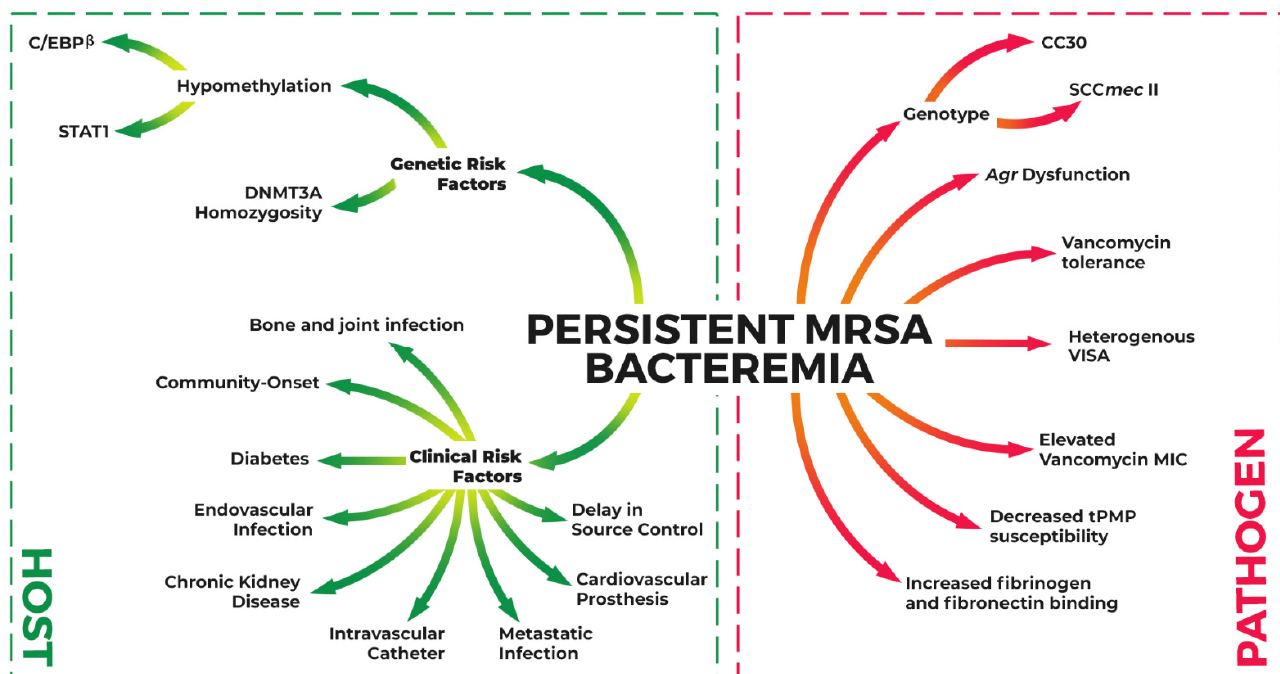
Figure 3. Summary of host and pathogen factors contributing to persistent MRSAB.